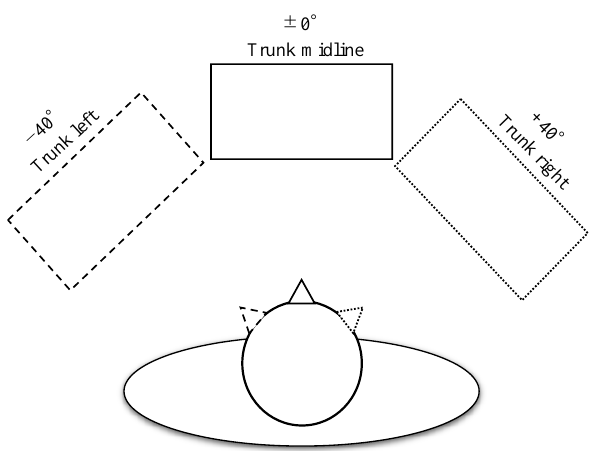
Figure 2. Trunk position. The horizontal position of the monitor was pseudo-randomly midline of the subject’s trunk (0 ◦ : trunk midline), 40 ◦ to the right (+40 ◦ : trunk right), or 40 ◦ to the left set to the midline of the subject ’ s trunk (0°: trunk midline), 40° to the right (+40°: trunk ( − 40 ◦ : trunk right), or 40° to the left ( − 40°: trunk left).